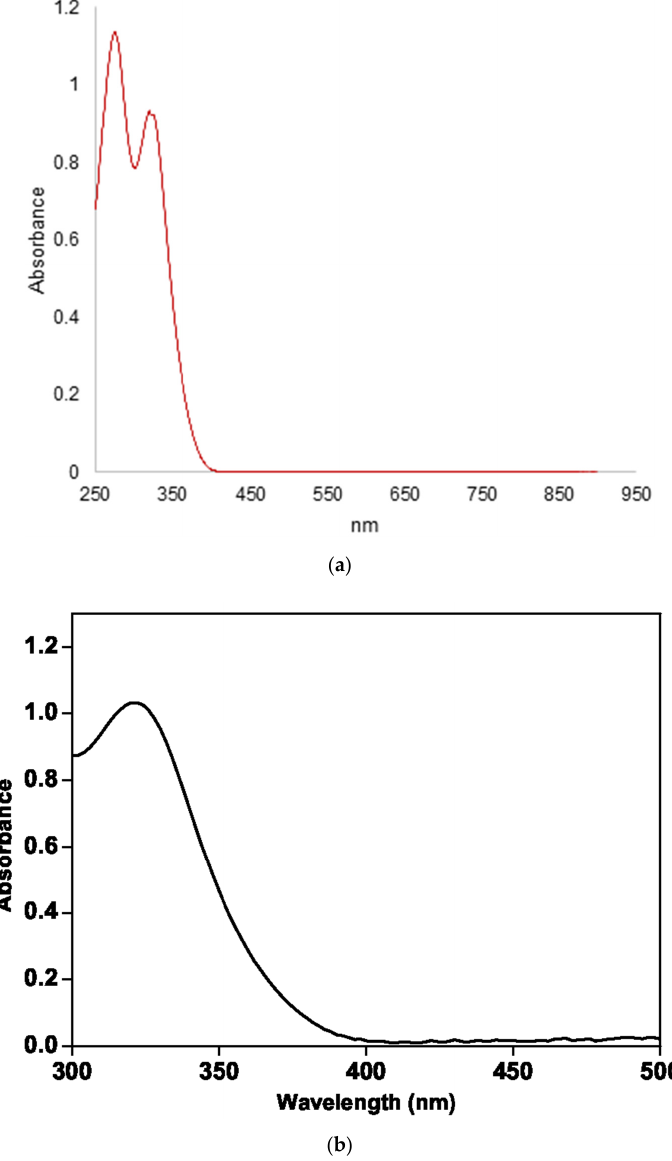
Figure 1. ( a ) UV-Visible absorption spectrum of TBADT in acetonitrile; ( b ) UV-Visible absorption spectrum of BT.